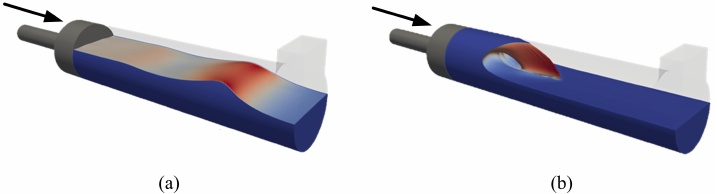
Figure 9. The two extrema of the plunger speed during the first phase of the high-pressure die casting process: ( a ) plunger speed too low; ( b ) plunger speed too high. The arrows indicate the direction of motion of the